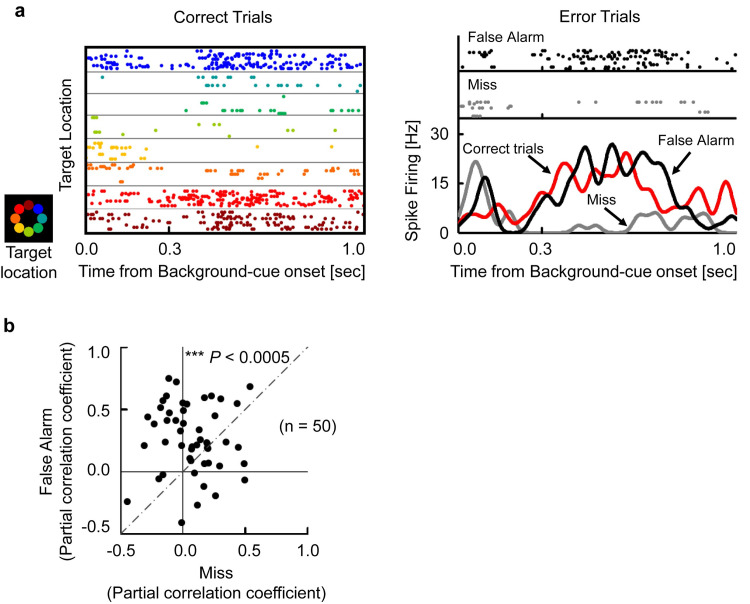
Neuronal signal predicting animals’ behavior.(a) Example neuron exhibiting target-selective activity. (Left) Raster displays of correct trials sorted by target locations. Colors indicate target locations on display. The neuron exhibited preferred responses when the target location was the top left (red). (Right) Raster displays of error trials and SDFs (σ = 20 milliseconds). False Alarm, top left as the incorrect positions the subjects chose (black). Miss, top left as the correct positions the subjects missed (gray). Correct trials, top left as the correct positions the subjects chose (red). (b) Error analysis for target-selective neurons with at least 10 error trials (n = 50). False Alarm, the false positions the subjects chose. Miss, the correct positions the subjects missed. Each dot indicates 1 neuron. ***P < 0.0005, Wilcoxon’s signed-rank test, 2-tailed. Source data are available in S1 Data. SDF, spike density function.